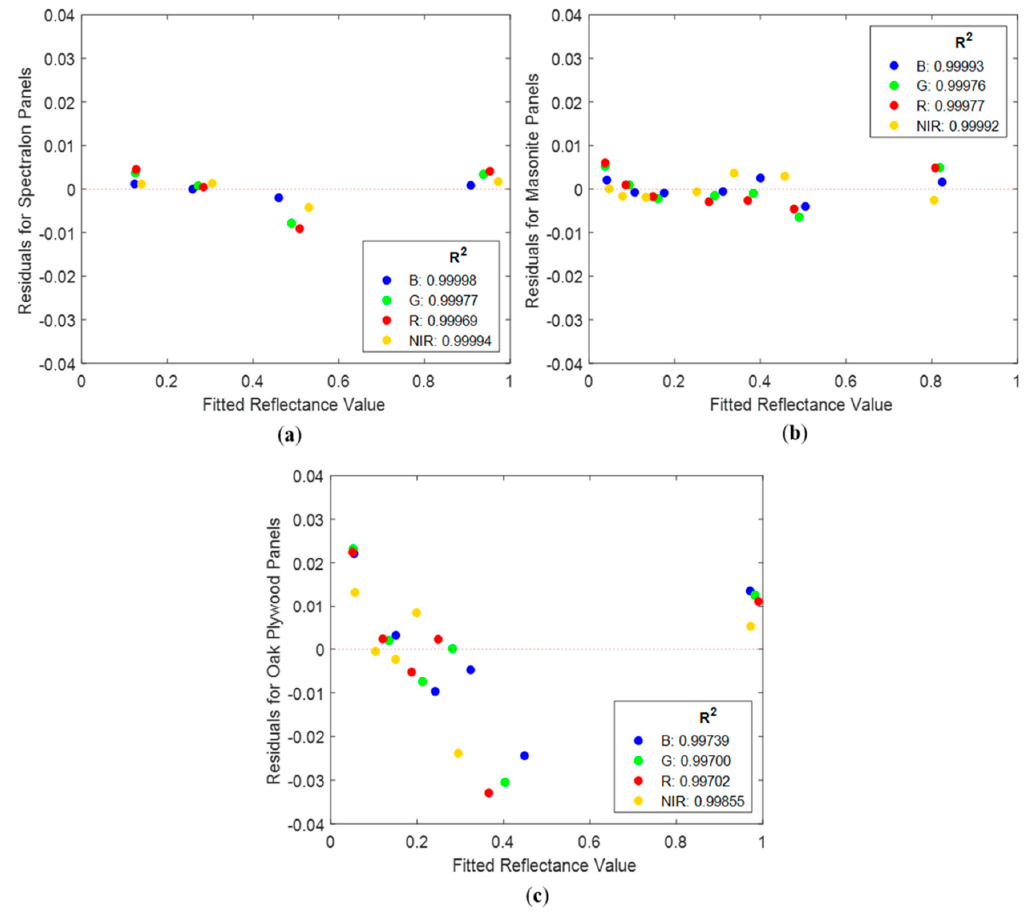
Figure 7. Residuals vs. fitted reflectance plots for ( a ) Spectralon, ( b ) Masonite, and ( c ) oak plywood panels. Blue dots correspond to a wavelength of 447 nm in the blue region of the spectrum, green dots to a wavelength of 554 nm in the green region, red dots to a wavelength of 652 nm in the red region, and yellow points to a wavelength of 850 nm in the NIR region. The legend is accompanied by R 2 of the regression for the specific wavelengths.